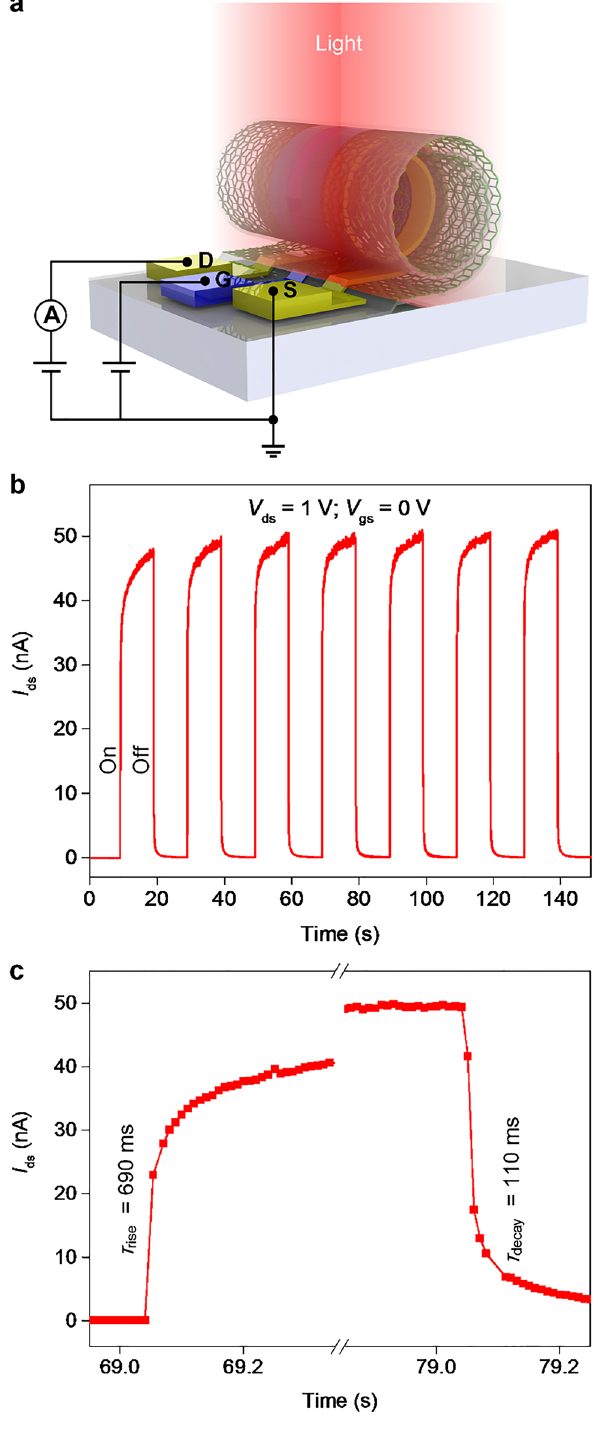
Figure 3: Photoresponse properties of the photodetector based on the 3D MoS 2 FET. (a)Schematicdiagramoftheexperimentsetup;(b)thetemporalresponse of the 3D MoS 2 FET photodetectors at V ds = 1 V and V gs = 0 V, under 660-nmLEDilluminationwiththeincidentlightintensityof14.7mW/cm 2 ; (c) the time-resolved photoresponse of the 3D MoS 2 FET. 3D, three- dimensional; FET, fi eld-effect transistor; MoS 2 , molybdenum disul fi